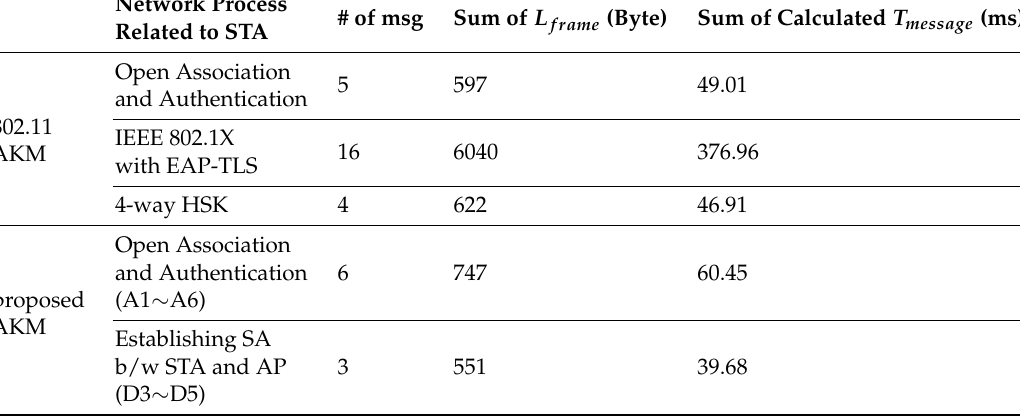
Table 6. Network cost of STA in 802.11 AKM and the proposed AKM over IEEE 802.11ah network.